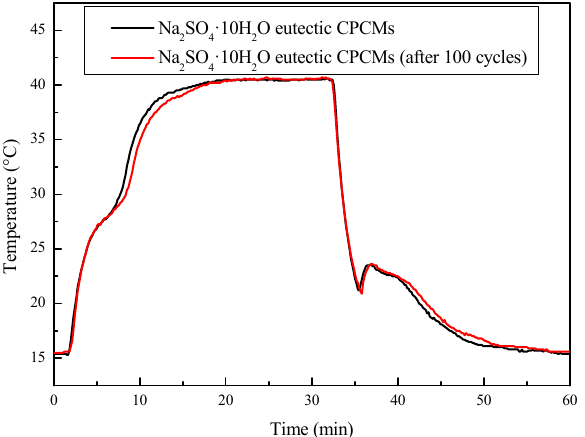
Figure 16. Cooling curves of the Na 2 SO 4 ·10H 2 O eutectic CPCMs before and after 100 melting–freezing cycles.